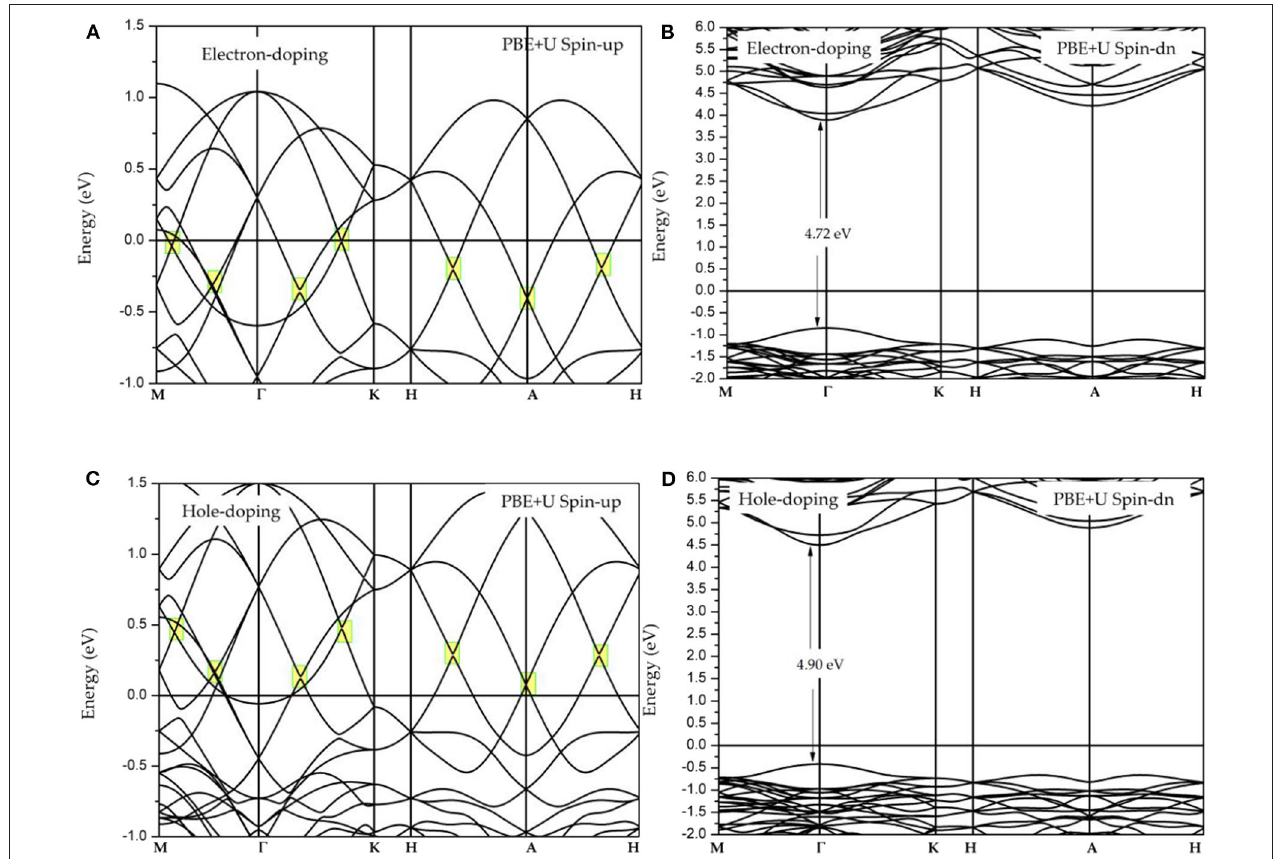
FIGURE 7 | V / V 0 ratio as a function of the pressure (temperature) at different given temperatures (pressures).